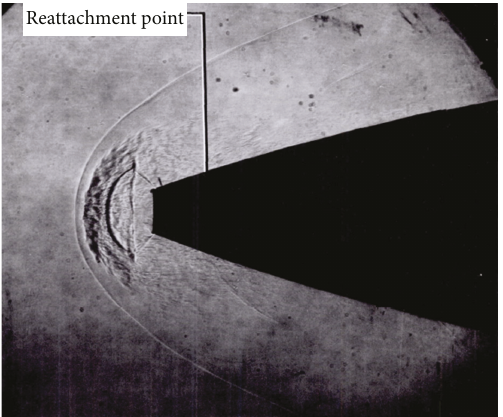
Figure 16: Gasjet experiment, blowing at fl at nose 0.91 kg/S, Re = 4 3 × 10 6 , α = 0 0 ° , M = 6 8 , Nowak